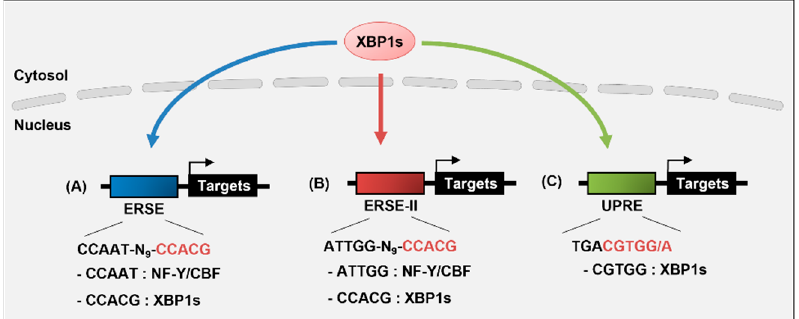
Figure 2. Cis -acting elements of XBP1s. XBP1s is an active transcription factor and plays an important role in the transcriptional regulation of UPR target genes encoding ER chaperones, folding enzymes, and ERAD components. XBP1s binds to three cis -acting elements: ERSE, ERSE-II, and UPRE. ( A ) ERSE has the consensus sequence of CCAAT-N 9 -CCACG and is located in the promoter of several genes, such as ER chaperones ( Hspa5 , Hsp90b1 , and Calr ), Ddit3 , and Xbp1 . ( B ) ERSE-II has the consensus sequence of ATTGG-N-CCACG and is located in the promoter of Herpud1 . The CCACG of ERSE and ERSE-II is the binding site for XBP1s or ATF6, and ATTGG is the binding site for NF-Y/CBF. ( C ) UPRE has the consensus sequence of TGACGTGG/A and XBP1s preferentially binds to CGTGG of UPRE.